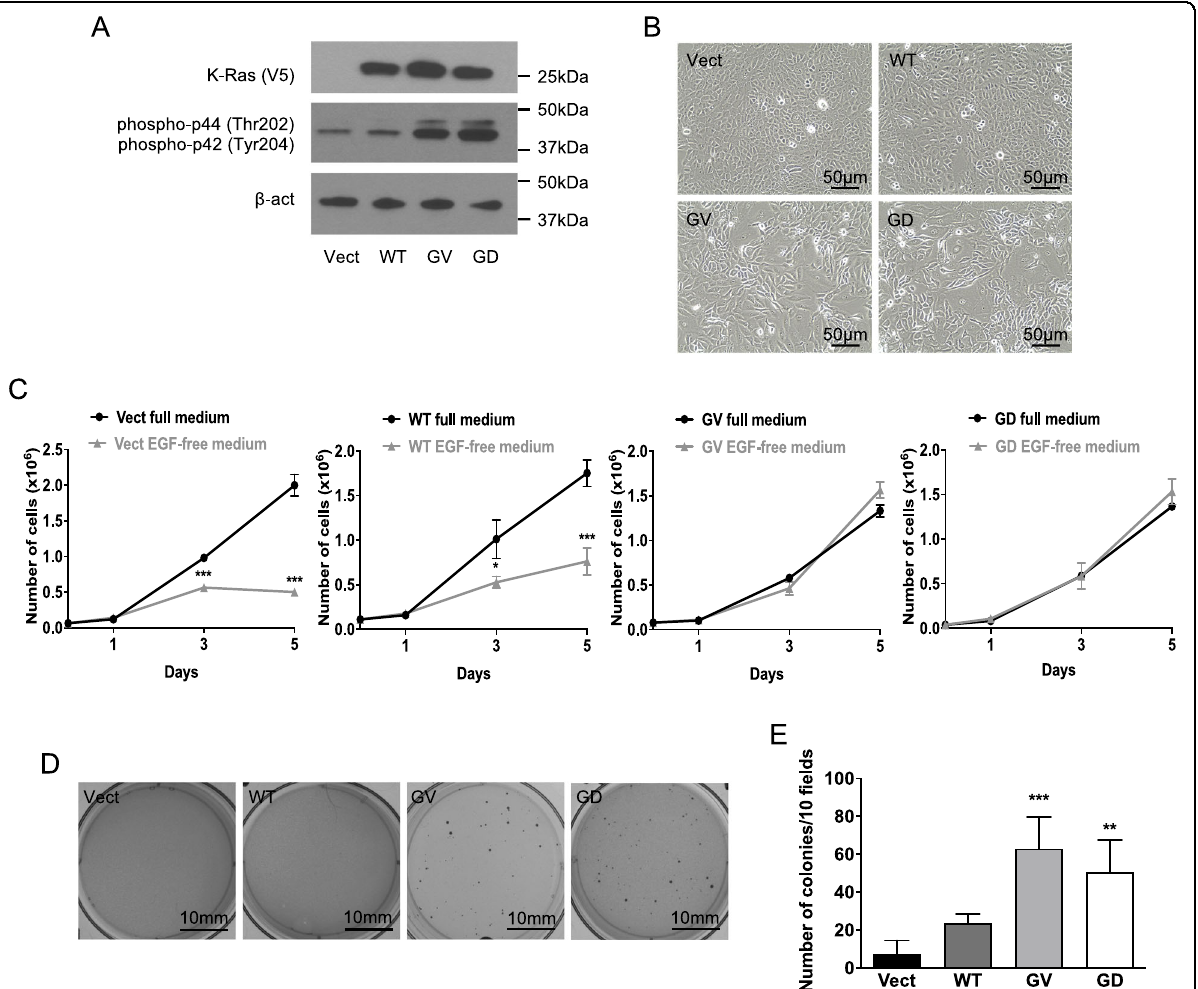
Fig. 1 Mutant K-Ras overexpression induces cell transformation. A Western blot analysis of protein extracts from cells overexpressing Vector, WT, GV, or GD K-Ras cultured for 48 h. The overexpressed proteins WT K-Ras and mutant K-Ras GV and GD are V5-tagged. V5 tag, phosphoERK1/2, and ß- actin were used as primary antibodies. B Observation of morphology of cells overexpressing Vector, WT, GV, or GD K-Ras after 48 h in culture using the bright fi eld. Cell morphology varies across different conditions. C Cell growth analysis using quanti fi cation of the cell number over the course of 5 days in culture. Cells overexpressing Vect, WT, GV, or GD K-Ras were plated in a growth medium that contains EGF. The next day, called day 0, the medium was changed to either growth medium (full medium, in black) or growth medium where EGF was not added (EGF-free medium, in gray). Cells were trypsinized and number of viable cells was determined using a hemocytometer after 1, 3, and 5 days ( N = 4, data presented as mean ± SEM, two-way ANOVA with Sidak ’ s multiple comparisons test, * means p < 0.05 comparing the group full medium to the group EGF-free medium at the same time point). D Colony formation assay using cells overexpressing Vect, WT, GV, or GD K-Ras. Cells were plated and cultured in soft agar for 2 weeks and then fi nally stained overnight using a membrane-permeable dye that stains viable cells. E Quanti fi cation of the number of colonies obtained after culturing cells overexpressing Vect, WT, GV. or GD K-Ras for 2 weeks in soft agar ( N = 4, data presented as mean ± SEM, one-way ANOVA with Dunnett ’ s multiple comparisons test, * means p < 0,05 comparing the tested groups to the group control